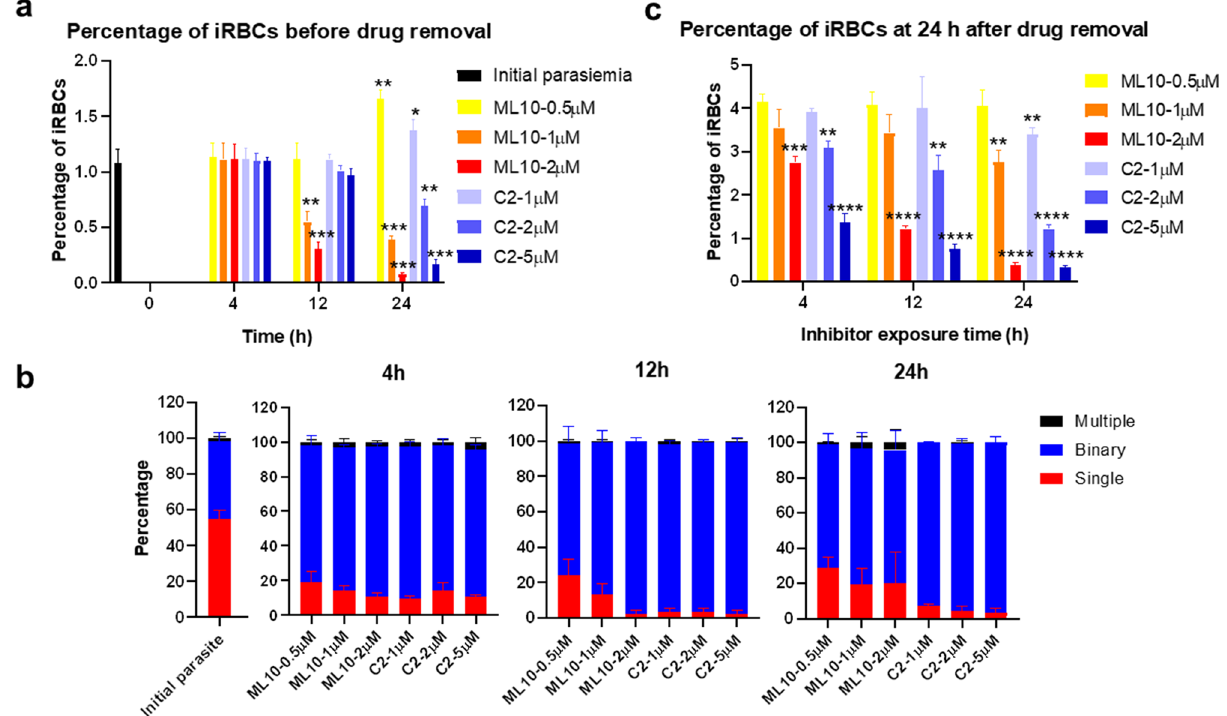
Figure 3. Impact of ML10 and C2 concentration and length of exposure on egress block and parasite viability. ( a ) Parasites were cultured in presence of 0.5, 1 or 2 μM of ML10 or 1, 2 or 5 μM of C2 for 4, 12, or 24 h. The initial percentage of iRBCs was ~ 1% and percentages of iRBCs in presence of drugs were calculated. The data are shown as mean ± S.D. of triplicate culture. Statistical comparisons were done between each group and initial percentage of iRBCs. (* P < 0.05; ** P < 0.01; *** P < 0.001; determined by unpaired t test). ( b ) The proportion of ring, binary, and multiple stages in presence of ML10 or C2 for 4, 12, or 24 h. The data are shown as mean ± S.D. of triplicate culture. ( c ) Cultures that were exposed to different concentrations of ML10 or C2 for 4, 12, or 24 h were washed and allowed to grow in fresh medium for 24 h. The statistical significance of the difference between each group and parasite treated for 4 h of 0.5 μM of ML10 or 1 μM of C2 determined by unpaired t test. (** P < 0.01; *** P < 0.001; **** P < 0.0001). The data are shown as mean ± S.D. of triplicate